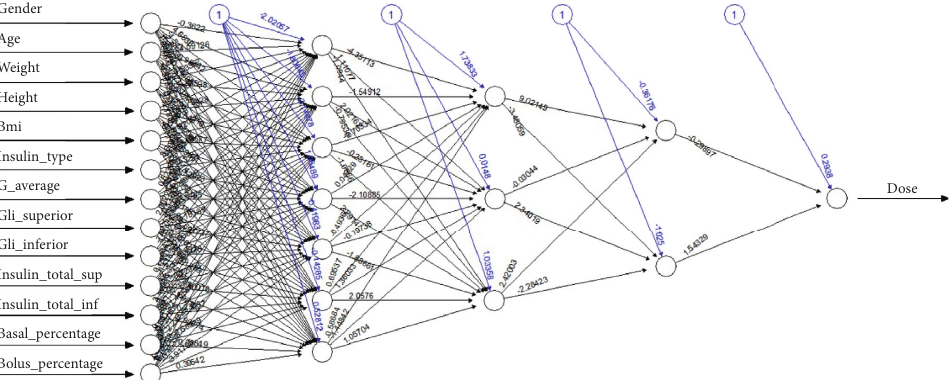
Figure 1: Structure of the neural network model